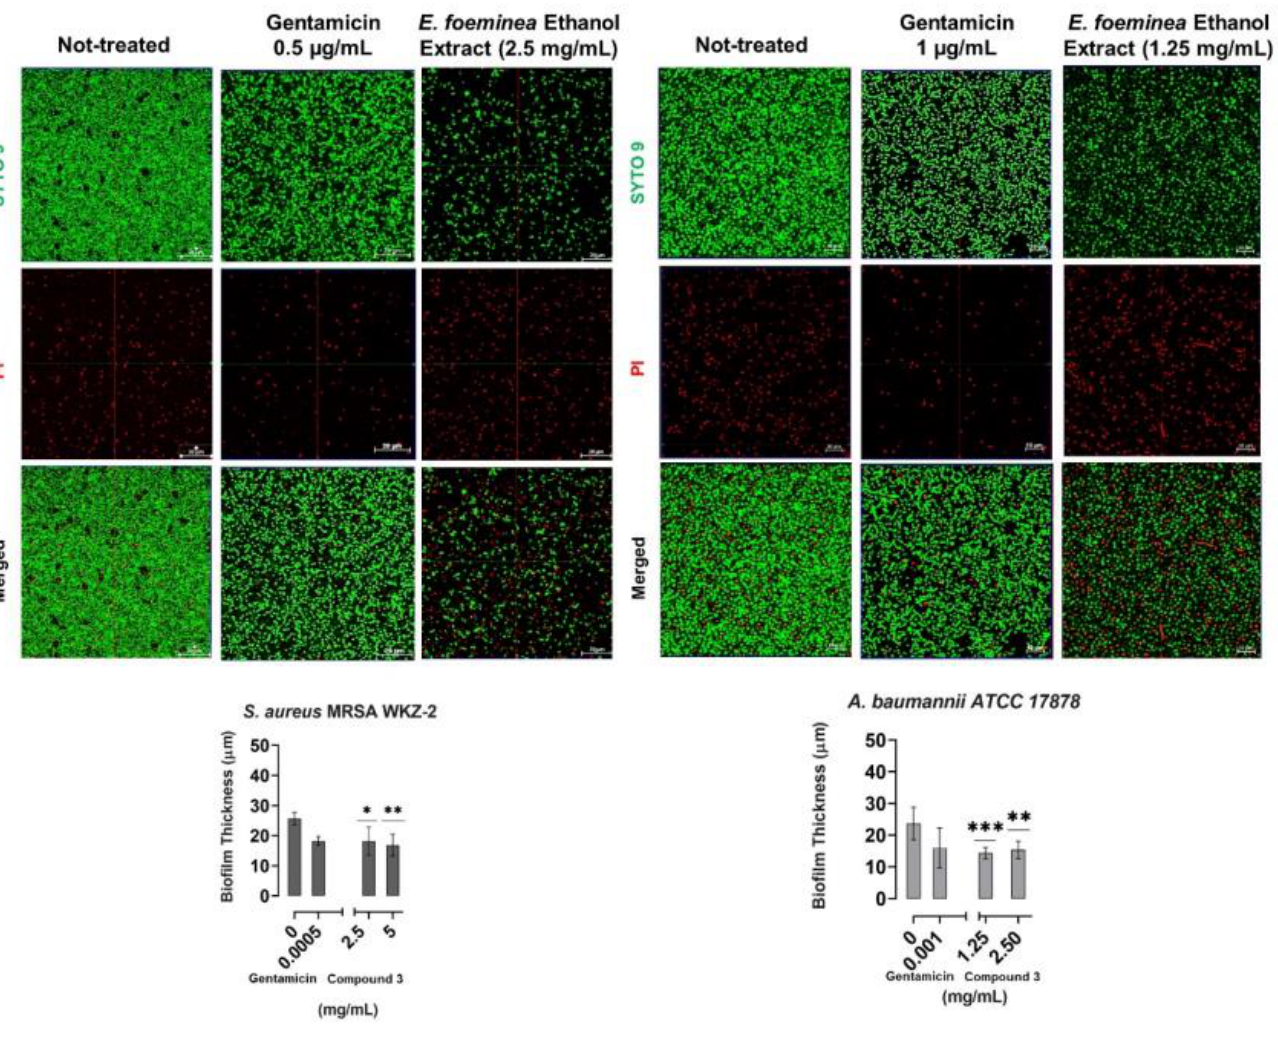
Figure 6. Antibiofilm activity of E. foeminea ethanolic extract. Effects of E. foeminea ethanolic extract